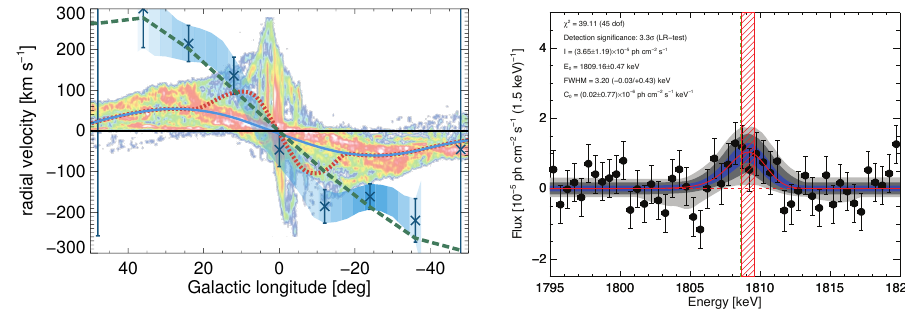
Figure 6. Left: The 26 Al decay line shows systematic shifts along Galactic longitudes, which are attributed to large scale Galactic rotation [34]. Excess velocities of about 200 km s − 1 are observed with respect to other tracers of Galactic rotation (colour scale: CO clouds). This is attributed to on-average larger streaming velocities in cavities elongated into the forward direction of galactic rotation [35]. Right: 26 Al line spectrum from the Orion region, indicating blue shifted emission from bulk motion towards the observer